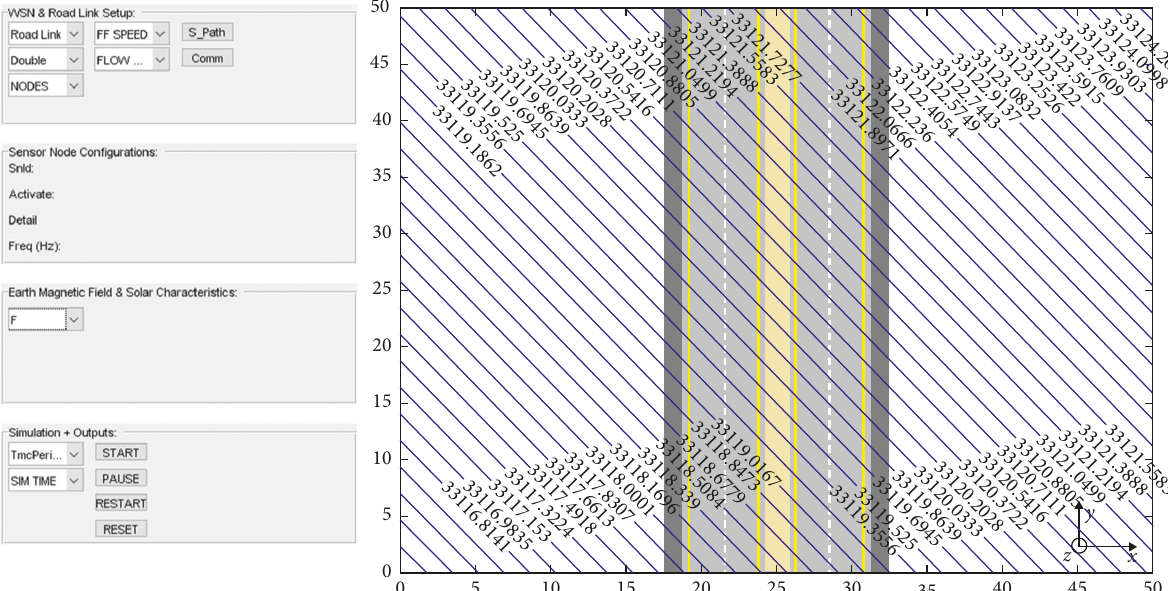
Figure 9: Simulator interface shows road link and the total Earth’s magnetic field contours in Dar es Salaam City located at latitude − 6.8 ° and longitude 39.1 ° .